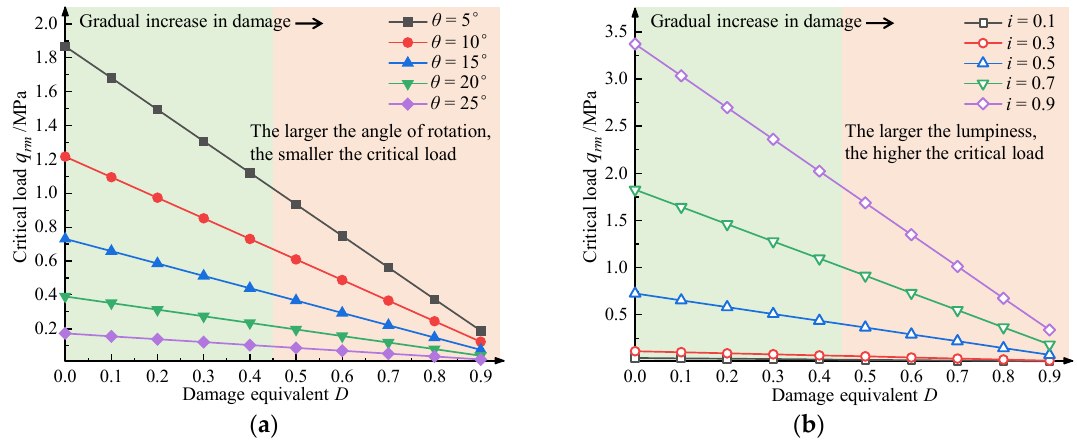
Figure 10. Rotary instability of the damaged key block. ( a ) Influence of the inclination factor ( b ) Influence of the lumpiness factor.